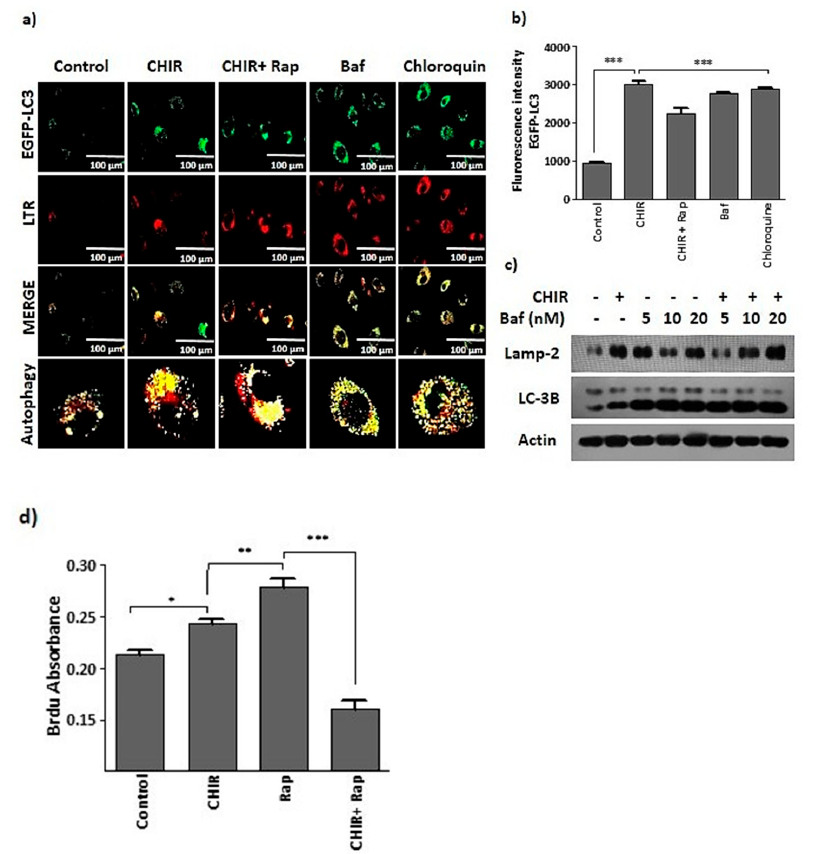
Figure 3. The suppression of GSK-3 β using CHIR99021 upregulates lysosome activation and au- tophagy. ( a , b ) EPCs were transfected with GFP-LC3 plasmid using Lipofectamine 3000 reagent. Then, cells were selectively treated with CHIR99021 (3 uM), rapamycin (20 nM), lysosomal blocker bafilomycin A1 (5 nM) and autophagy blocker chloroquine (20 uM) for 4 h. Next, cells were co-stained with lysotracker (200 nM) for 1 h. GFP-LC3 expression was captured using a 40× objective lens on a Lion Heart FX automated microscope. Scale bar = 100 μ M. ( c ) The cells were treated with CHIR99021 (3 uM) alone or co-treated with bafilomycin A1 (5, 10, 20 nM) for 4 h, then Western blots were generated to detect the expression of lysosomal marker proteins LAMP2 and autophagy marker protein LC-3B. Actin was taken as a loading control. ( d ) The cells were selectively treated with CHIR99021 (3 uM) for 24 h, rapamycin (20 nM) and bafilomycin A1 (5 nM) for 1 h. BrdU in- corporation was absorbed at 450 nm to assess the proliferation. Data are presented as mean ± standard error of the mean (SEM). The results are considered statistically significant at * p < 0.05; ** p < 0.01; *** p < 0.001 when compared to untreated groups, and ns (no significant). (Baf—bafilomycin A1,